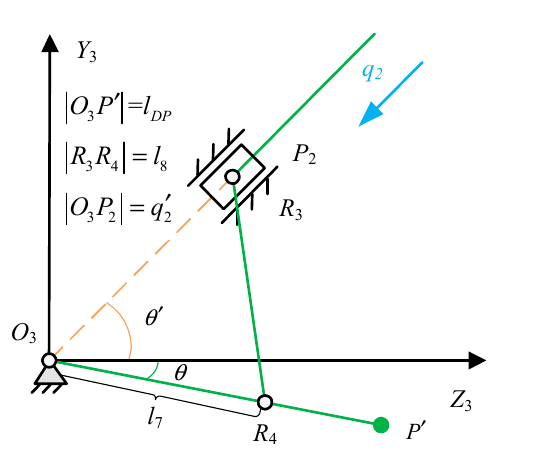
Figure 7. The schematic diagrams of the PIP joint mechanism.